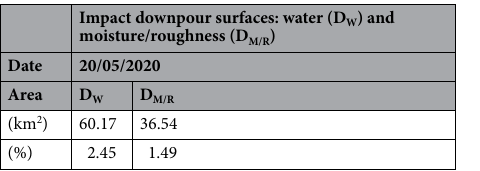
Table 7. Results obtained from water surfaces and moisture/roughness surfaces at downpour of the 20/05/2020.